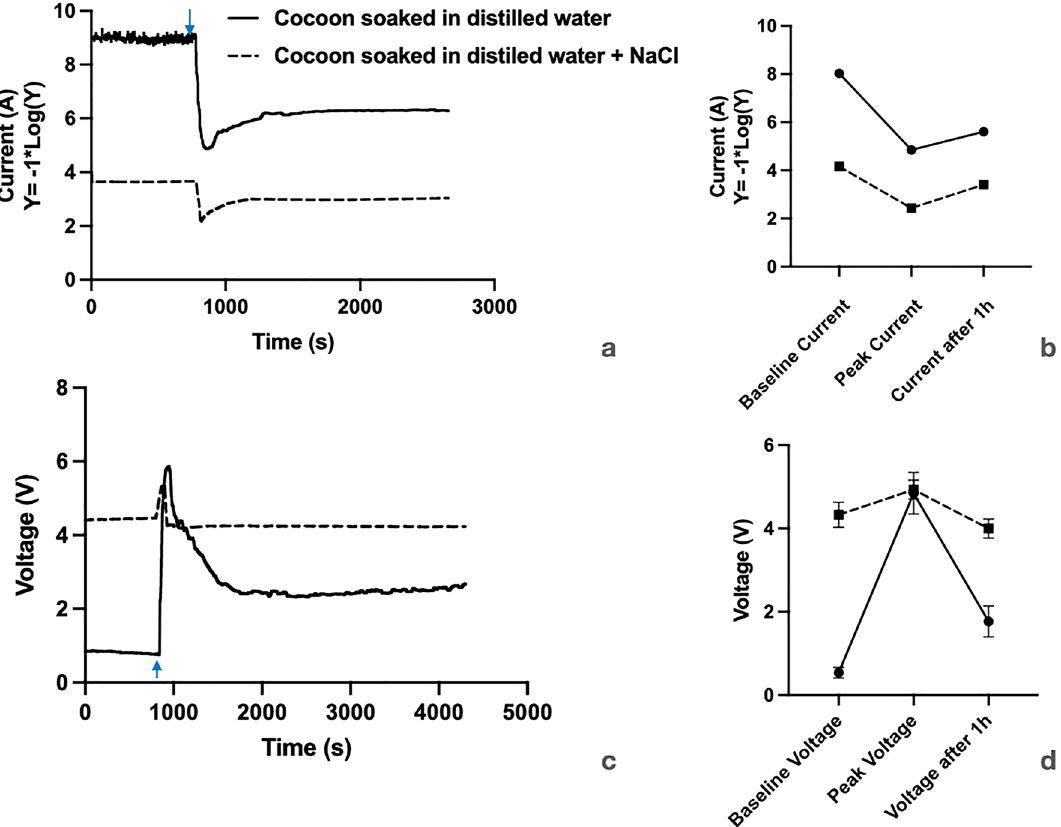
Figure 3. Electrical properties of the silk cocoon devices. ( a ) Comparing a representative current trace from devices prepared from the distilled water-soaked cocoon and NaCl soaked cocoon. The current values are shown in the −1*Log (y) scale. The blue arrow indicates the 2 min time exposure of water vapor. ( b ) Comparing the current values of baseline, peak, and after one h for distilled water soaked and NaCl soaked cocoon devices. ( c ) Comparing a representative voltage trace from devices prepared from the distilled water-soaked cocoon and NaCl soaked cocoon. ( d ) Comparing the voltage values of baseline, peak, and after one h for distilled water soaked and NaCl soaked cocoon